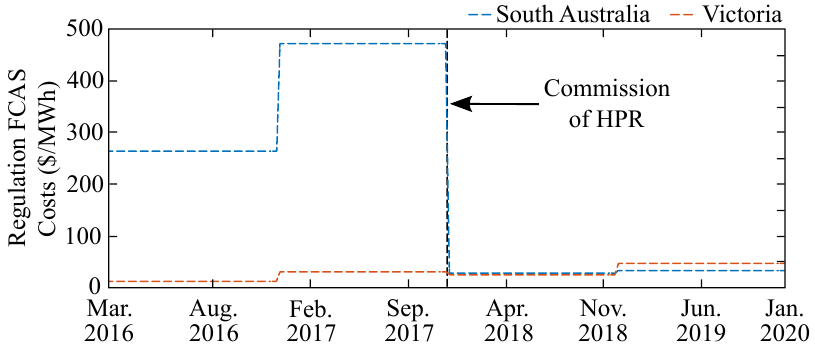
Figure 9. Decrease in regulation Frequency Control Ancillary Services (FCAS) costs due to the participation of the Hornsdale Power Reserve (HPR) battery (plot drawn with data from